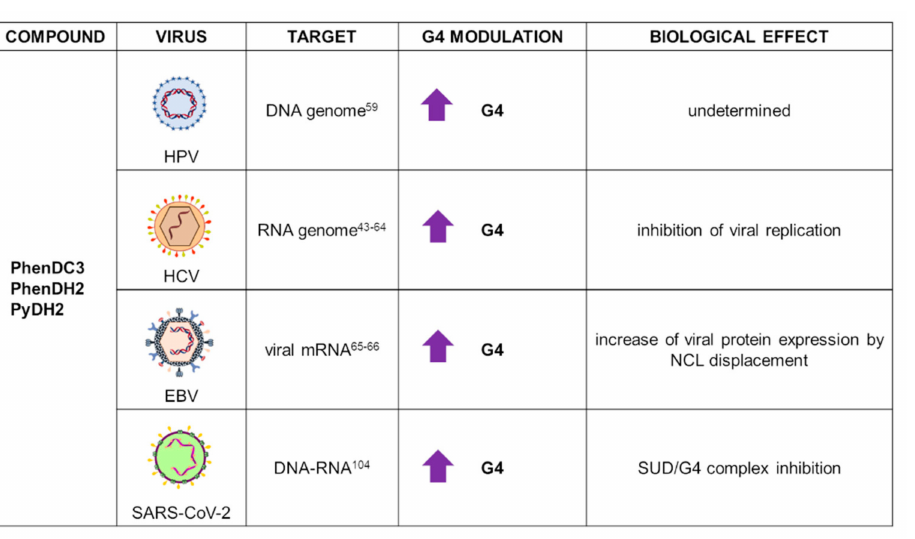
Figure 4. Summary of PhenDC3 and derivative applications as G4 ligands in virology. For each target virus, the site of action (also known as the G4 location), the modulatory effect on G4s, and the overall biological outcome are